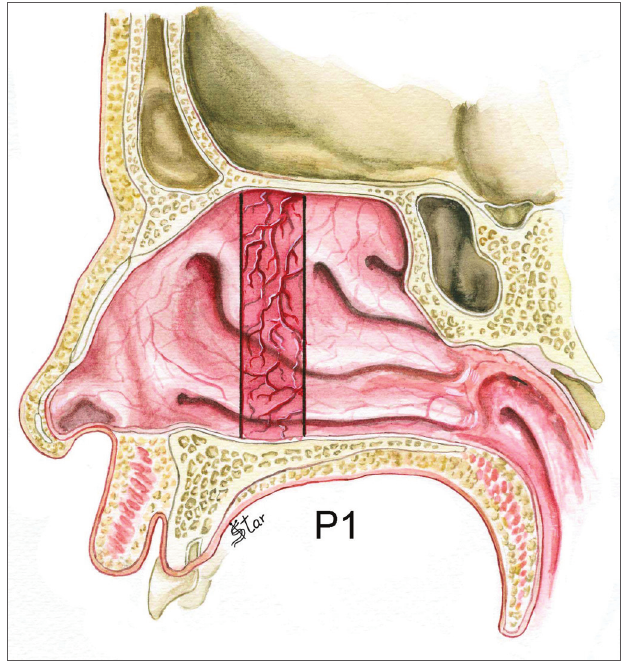
Figura 5. Estadiamento da PN no plano ântero-posterior - P1 - pólipos restritos à região do meato médio